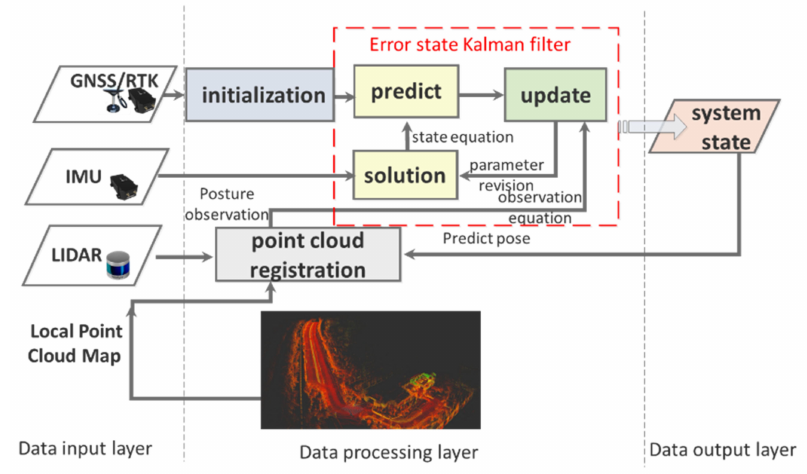
Figure 6. The location system framework.